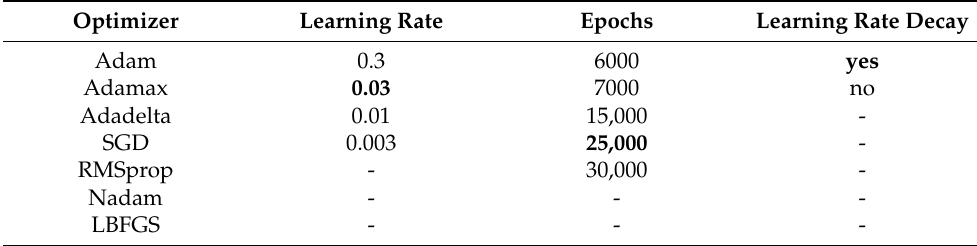
Table 2. List of the hyperparameters tested. The final choices used across all experiments are written in bold.